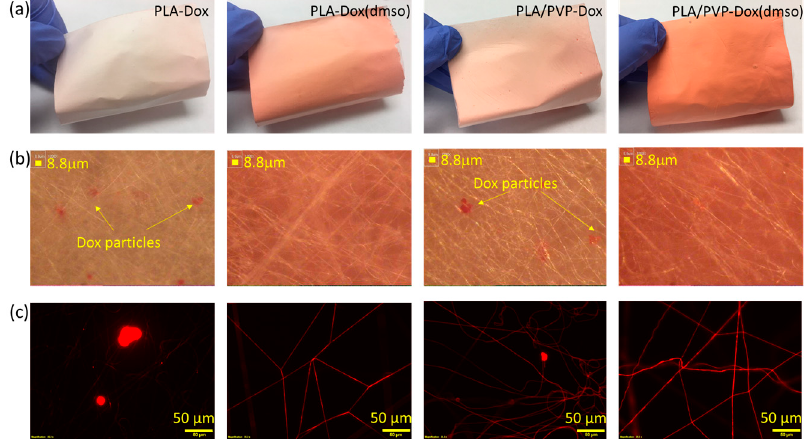
Figure 1. Doxorubicin-loaded fiber webs. ( a ) Photographic images of drug-loaded webs; ( b ) optical images displaying drug aggregates; ( c ) fluorescence images with Dox-loaded webs.